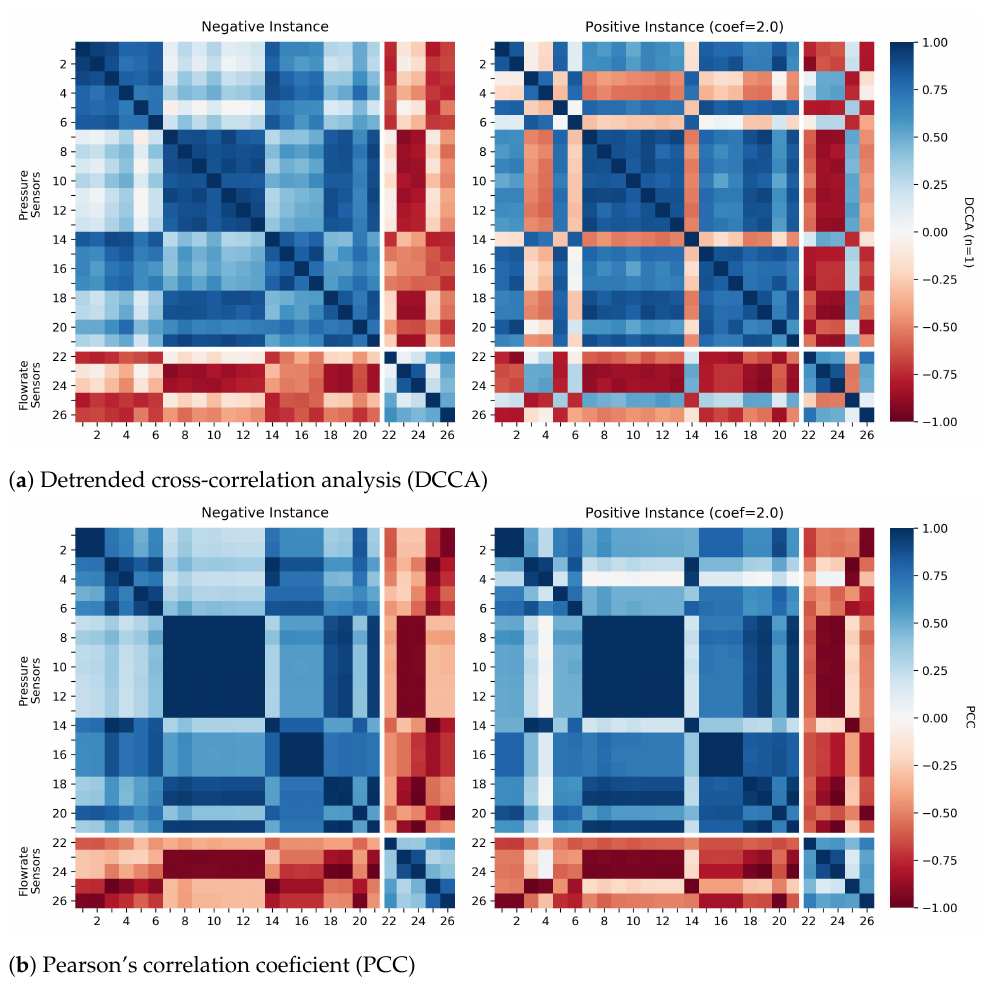
Figure 8. Correlograms of two synthetic instances from chunk 702 using a window of 40 time